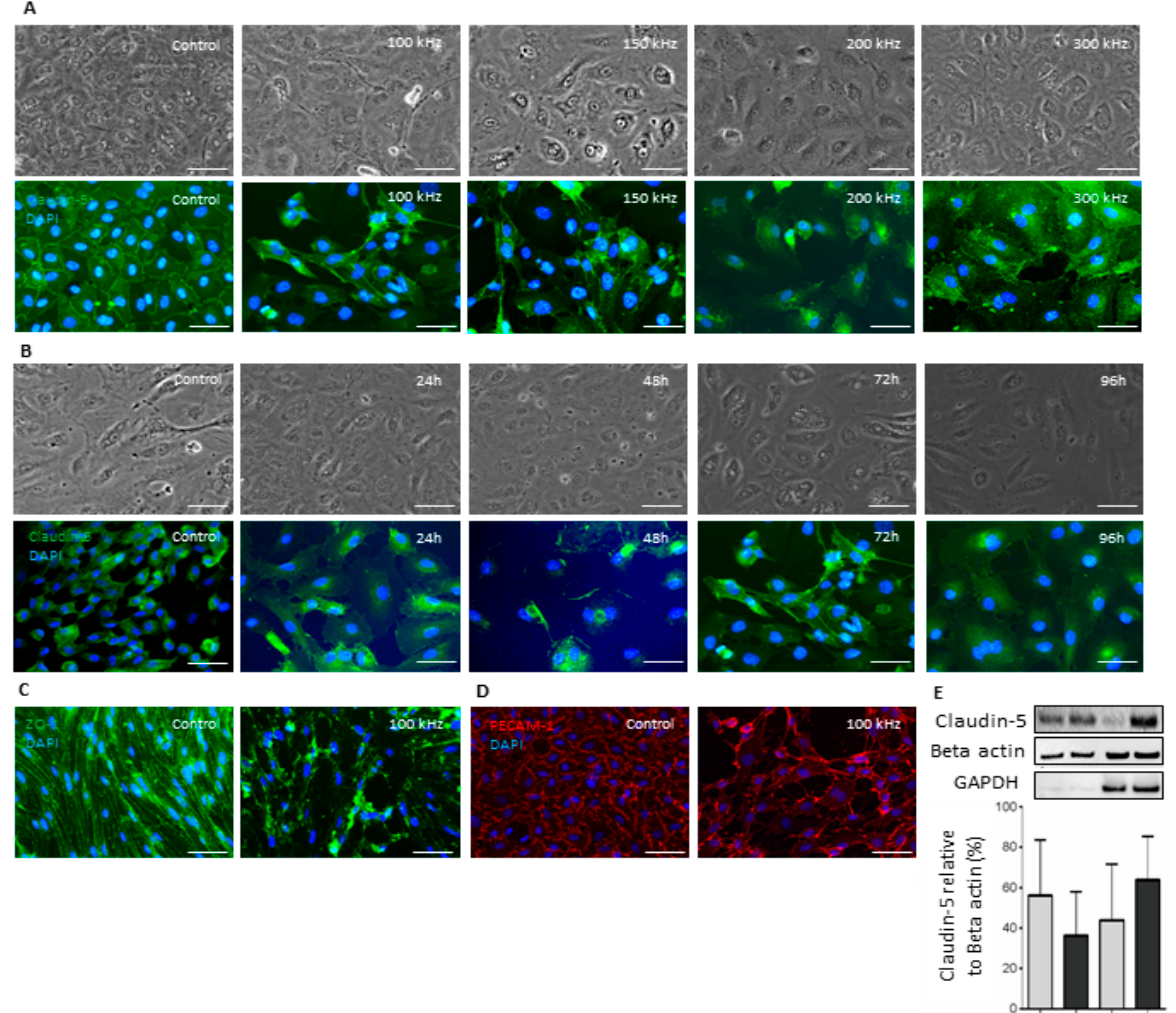
Figure 2. TTFields altered the localization of tight junctions and associated proteins. ( A ) Light microscope images of HBMVEC cells co-cultured with human pericytes ( upper panel ) and immunofluorescence staining of claudin-5 in the same cells ( lower panel ) treated with 100–300 kHz TTFields for 72 h. ( B ) Light microscope images of HBMVEC cells co-cultured with human pericytes ( upper panel ) and immunofluorescence staining of claudin-5 in the same cells ( lower panel ) treated with 100 kHz TTFields for 24–96 h. ( C , D ) Immunofluorescence staining of ( C ) ZO-1 and ( D ) PECAM-1 in HBMVEC subjected to TTFields at 100 kHz for 72 h. Images shown are representative of at least three independent experiments. Scale bar = 200 µm. ( E ) Western blot and densitometric analysis thereof of claudin-5 expression in fractionated HBMVEC, n = 3. Error bars represent the standard deviation.